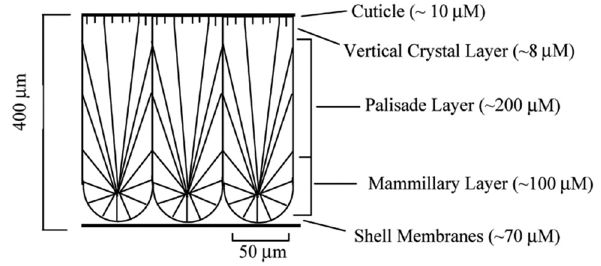
Figure 1: Schematic illustration of layers in a chicken ES [ 25 ]